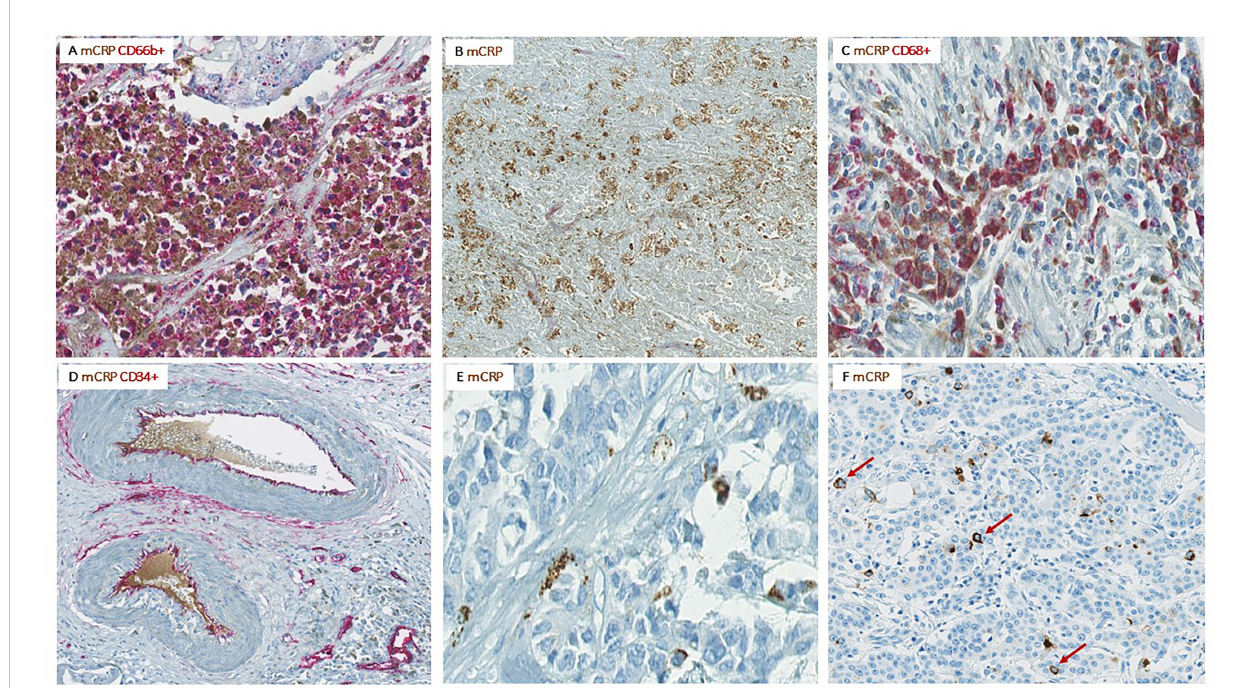
expression. (C) Colocalization of mCRP and macrophages. (D) Colocalization of mCRP and endothelial cells lining intratumoral vessels as well as some mCRP within the vessel lumen. (E) mCRP scattered diffusely as small granules within the connective tissue of the tumor stroma. (F) Tumor cell nuclei surrounded by mCRP (marked by arrows).